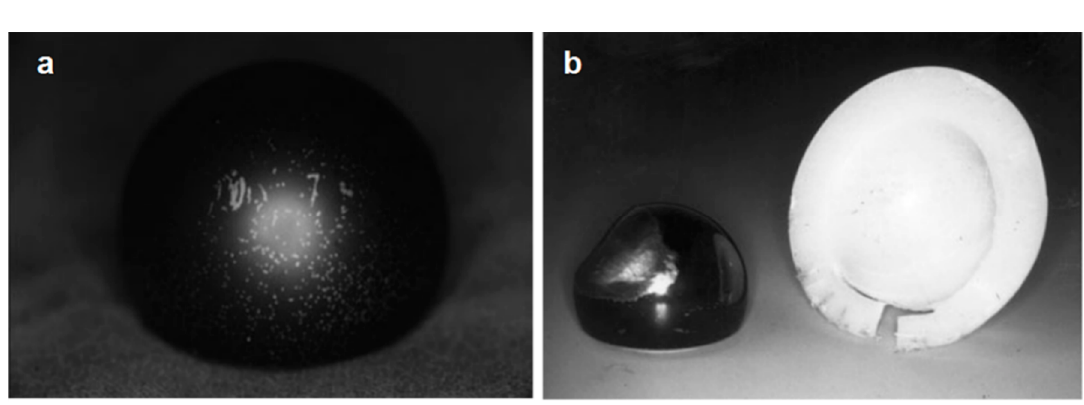
Figure 10. ( a ) Retrieved DLC-coated head: Lateral and cranial aspect articulated with the acetabular component (polyethylene). Numerous pits in the formerly articulating surfaces, revealing metallic substrate underneath. ( b ) DLC-coated head and corresponding acetabular surface. Substantial defects in the spherical deformed polyethylene caused by DLC particles. Consecutive abrasion of the metallic substrate (head) and metal backing of the socket. Adapted from [ 121 ] .